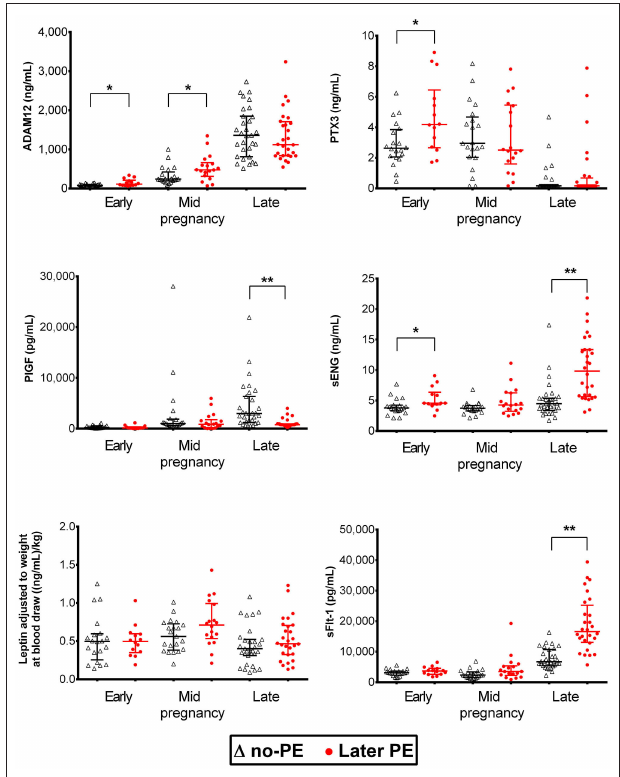
FIGURE 1 | Dynamics of preeclampsia-related biomarkers throughout gestation in healthy and preeclamptic pregnancies. Luminex ® 6PLEX assay measurement data of concentrations of ADAM12, PTX3, PlGF, sENG, and sFlt-1 in 132 serum samples collected from pregnant women. The early pregnancy group was comprised of 14 samples drawn at 70–98g days from women that later developed PE and 20 samples from controls collected at 76–96g days. The mid-pregnancy sample set comprised 18 PE and 21 control pregnancy sera, sampled at 100–180 and 109–182g days, respectively. Data of late pregnancy samples representing 28 PE (206–275g days) and 31 control sera (210–274g days) were obtained from our recent study (15). All women, irrespective of the pregnancy outcome (PE or no-PE), were normotensive at blood draw. The whiskers on the plot show the median with an interquartile range. The statistical difference in biomarker distributions between PE and control cases was compared using the Mann-Whitney U-test, * representing P < 0.05 and ** P < 0.0001. ADAM12, ADAM Metallopeptidase Domain 12; g days, gestational days; PlGF, placental growth factor; PTX3, Pentraxin3; sENG, endoglin; sFlt-1, soluble fms-like tyrosine kinase